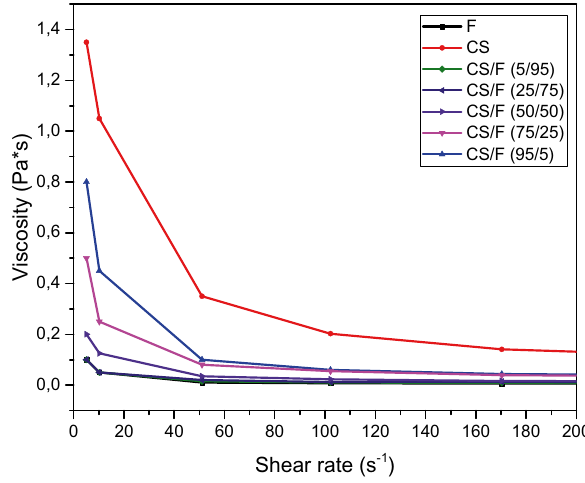
Fig. 6 Fluid compatibility curve as a function of viscosity vs shear rate